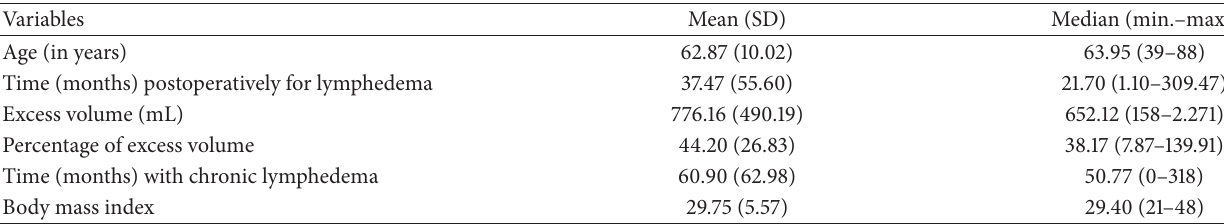
Table 1: Characteristics of patients before the